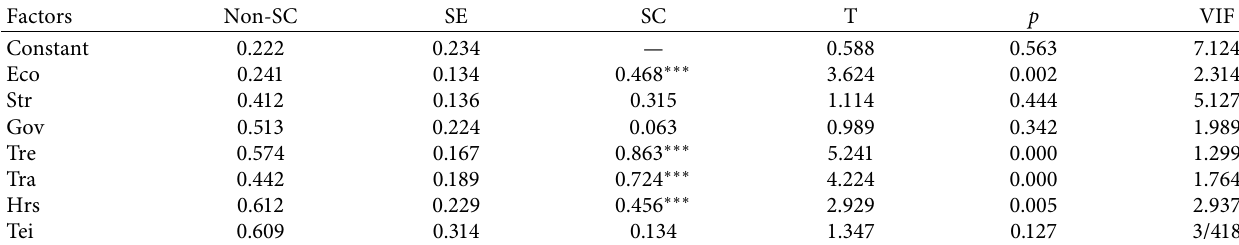
Table 6: Regression results of factors influencing the overall efficiency of inbound